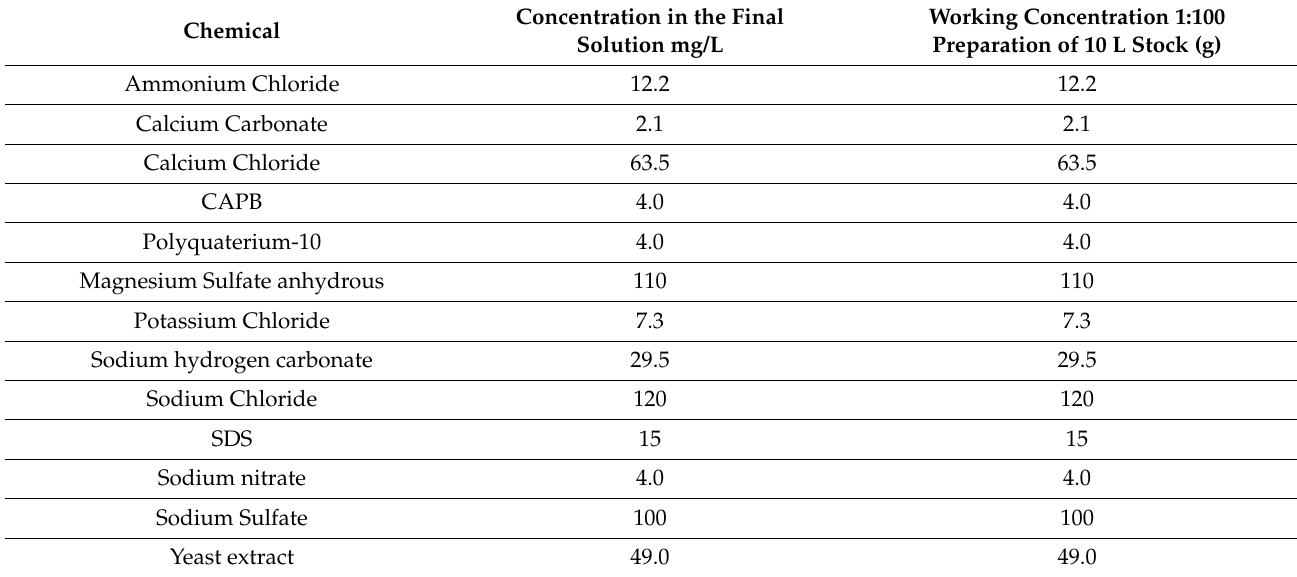
Table 1. Chemical composition of synthetic